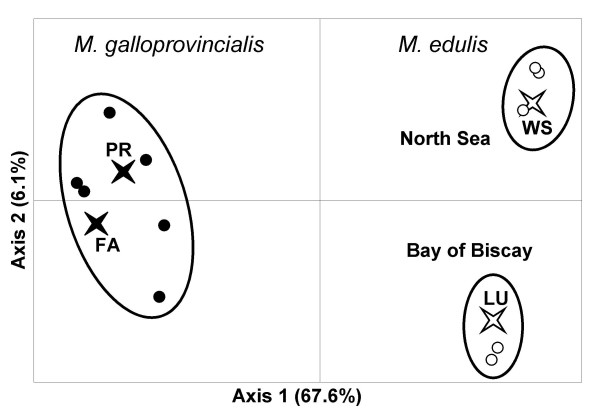
Projection of samples centers of gravity on the first factorial plane of a correspondence analysis (CA) on the matrix of allele frequencies at three loci (EFbis, Glu-5' and mac-1). The four samples representative of each species patch used for the analysis of DNA sequences are indicated by white and black stars for M. edulis and M. galloprovincialis respectively. The eleven samples previously analyzed [33] are indicated by white and black dots for M. edulis and M. galloprovincialis respectively. Ellipses group samples for which the homogeneity of allelic frequencies could not be rejected at the EFbis locus.